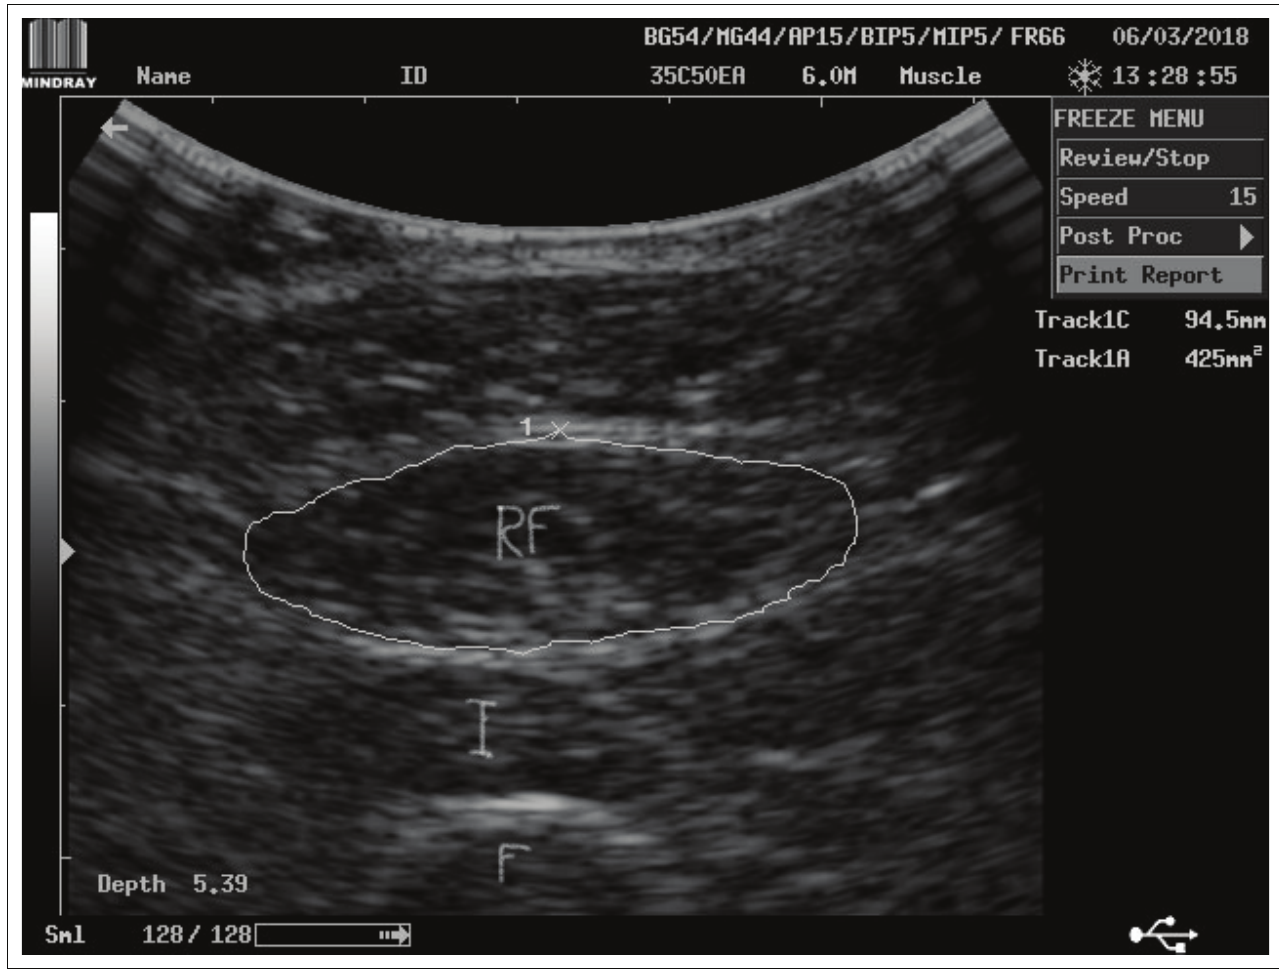
FIGURE 1: Example of measurement of cross-sectional area of the rectus femoris muscle of a healthy individual using on-screen callipers of the ultrasound diagnostic imaging